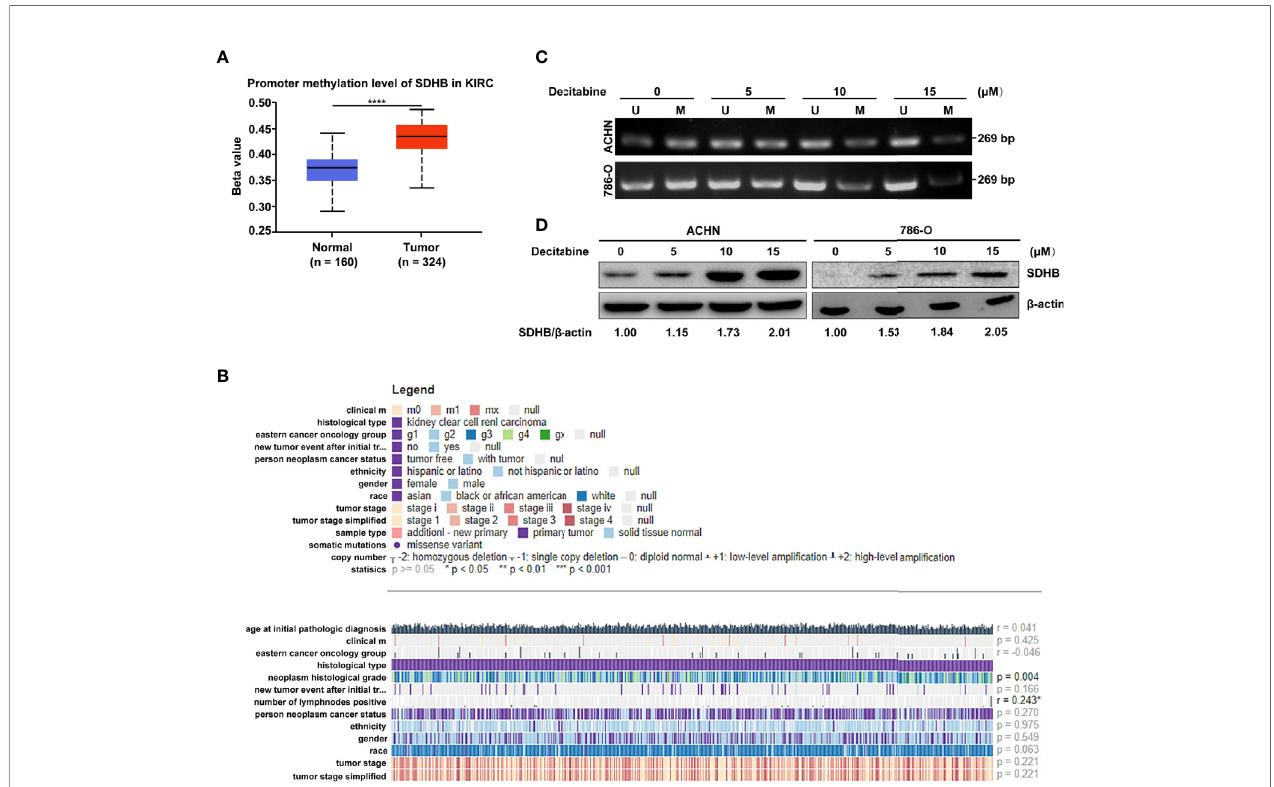
FIGURE 3 | High methylation levels in ccRCC promote the downregulation of SDHB. (A) Methylation levels of SDHB gene promoter was increased in ccRCC tissues based on the TCGA_KIRC data. The Beta value indicated the level of DNA methylation, and the P value was derived from independent sample two tailed t -test. The data were presented as mean ± SD. **** P < 0.0001. (B) The correlation between SDHB methylation levels and clinical parameters in the MEXPRESS database. (C) MSP analysis of SDHB gene promoter methylation in ACHN and 786-O cells following treatment with increasing dose of methylation inhibitor decitabine. Bisulphite-modi fi ed DNA was ampli fi ed with primer pair speci fi c for unmethylated (U) and methylated (M) alleles. The data are representative of three independent experiments. (D) Western blotting results showed that SDHB protein level was gradually increased in ACHN and 786-O cells following treatment with increasing dose of methylation inhibitor decitabine. b -actin was used as a loading control. The data are representative of three independent